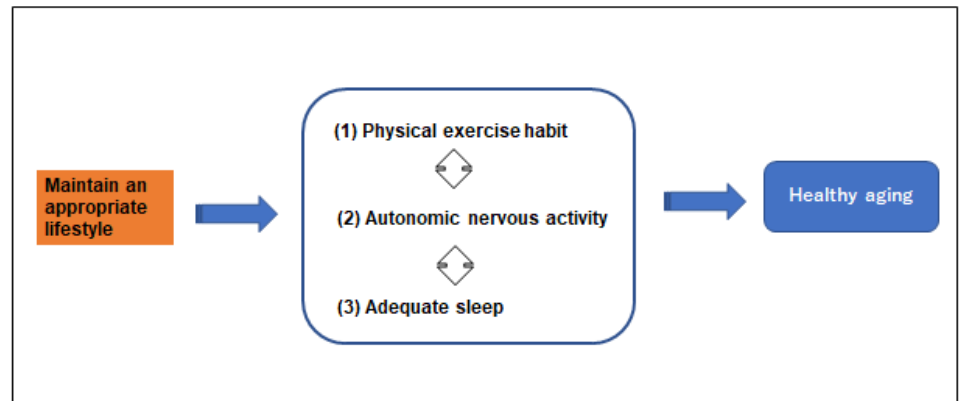
Figure 2. Relationship of maintaining an appropriate lifestyle for healthy aging as physical exercise habit, autonomic nervous activity, and an adequate sleep. habit, autonomic nervous activity, and an adequate